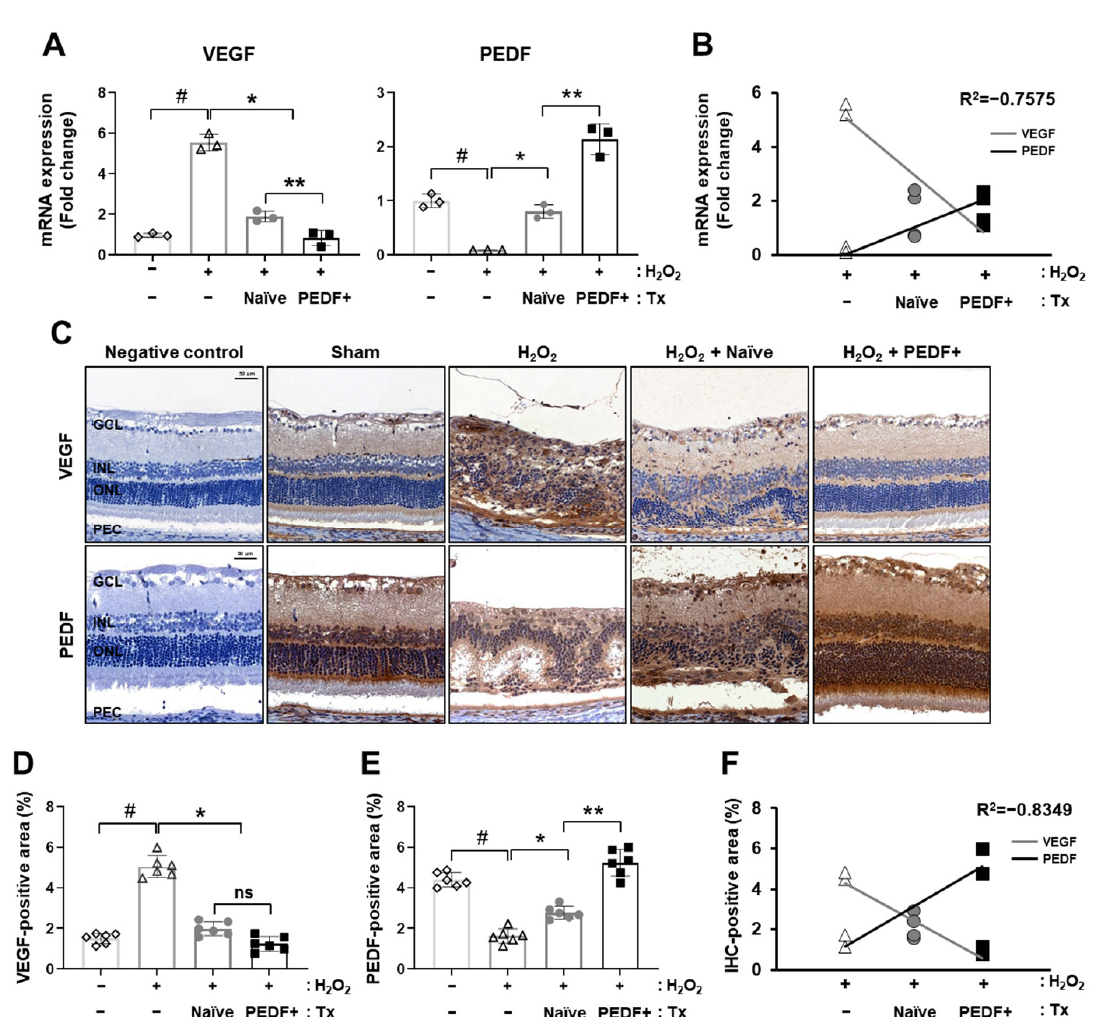
Figure 3. PD-MSCs PEDF balanced VEGF and PEDF levels in a H 2 O 2 -induced rat model. The mRNA expression of ( A ) VEGF and PEDF in H 2 O 2 -injured rat retinas after naïve PD-MSC (H 2 O 2 + Naïve) and PD-MSC PEDF (H 2 O 2 + PEDF+) transplantation. ( B ) The negative correlation between VEGF and PEDF was determined by qRT-PCR. ( C ) IHC staining and the intensities of ( D ) VEGF and ( E ) PEDF in the rat retina ( n = 6/group). ( F ) The negative correlation between VEGF and PEDF was determined by the percentages of IHC-positive areas (%). The data represent the mean ± SD and were analyzed by one-way ANOVA. # p < 0.05 vs. Sham ( − ), * p < 0.05 vs. H 2 O 2 , ** p < 0.05 vs. H 2 O 2 + Naïve.